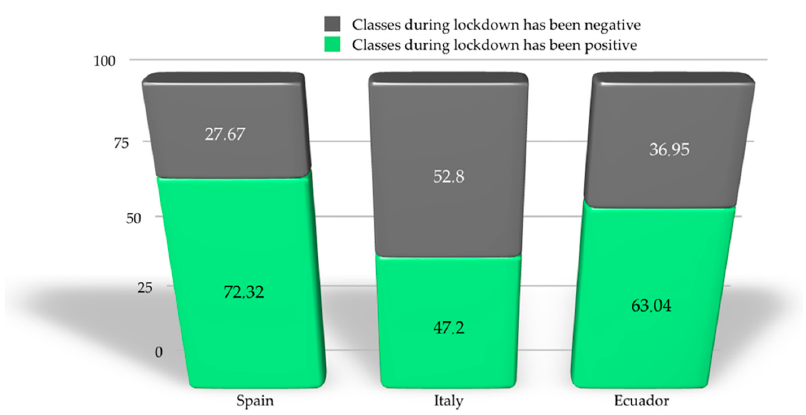
Figure 3. Student´s perception about classes during the lockdown.